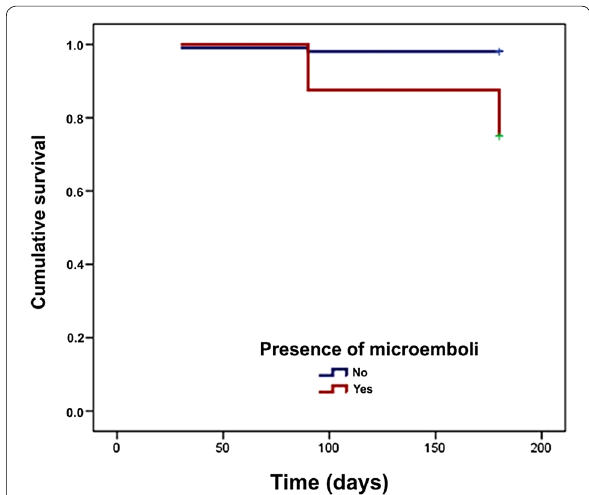
Fig. 3 Survival curves according to the presence of MES corrected by prior